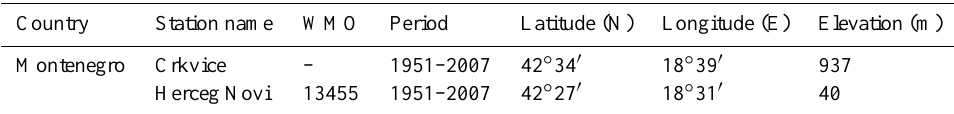
Table 1. List of stations. Country Station name WMO Period